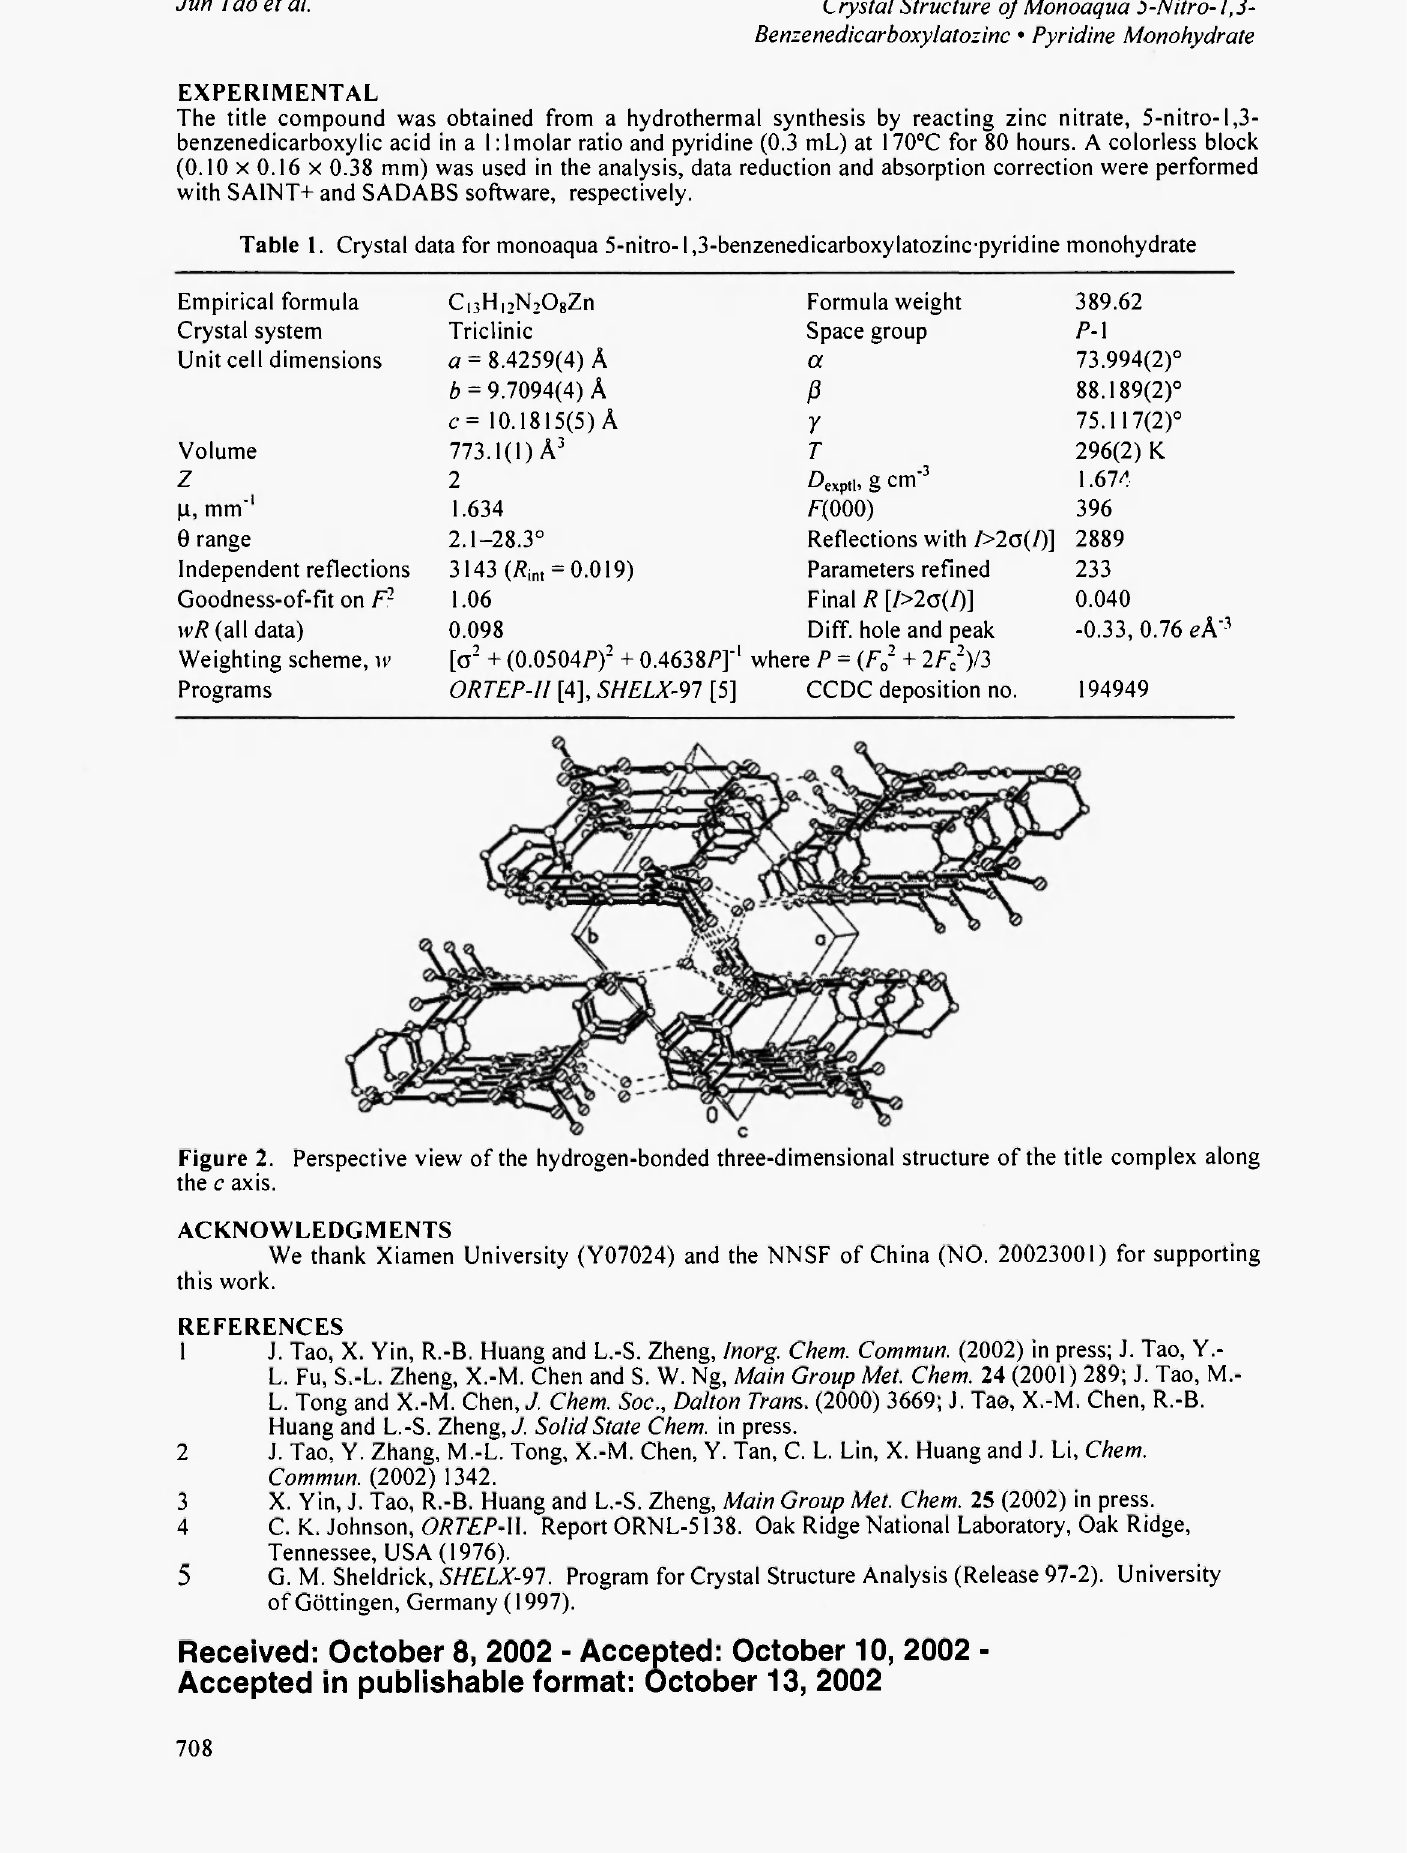
Figure 2. Perspective view of the hydrogen-bonded three-dimensional structure of the title complex the c axis.